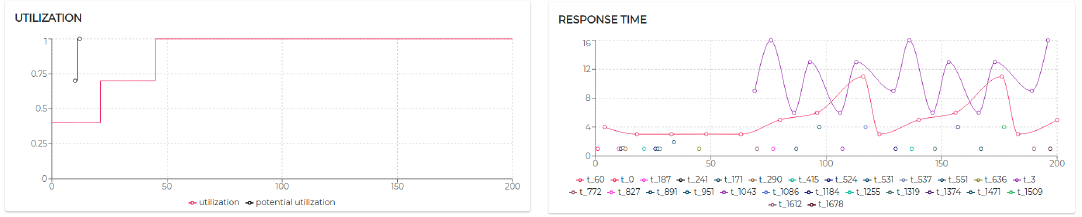
Figure 16. Agent 3 Utilization over the simulated time [0–200 s] in scenario S3rt; y-axis: utilization (adimensional); x-axis: time (seconds).